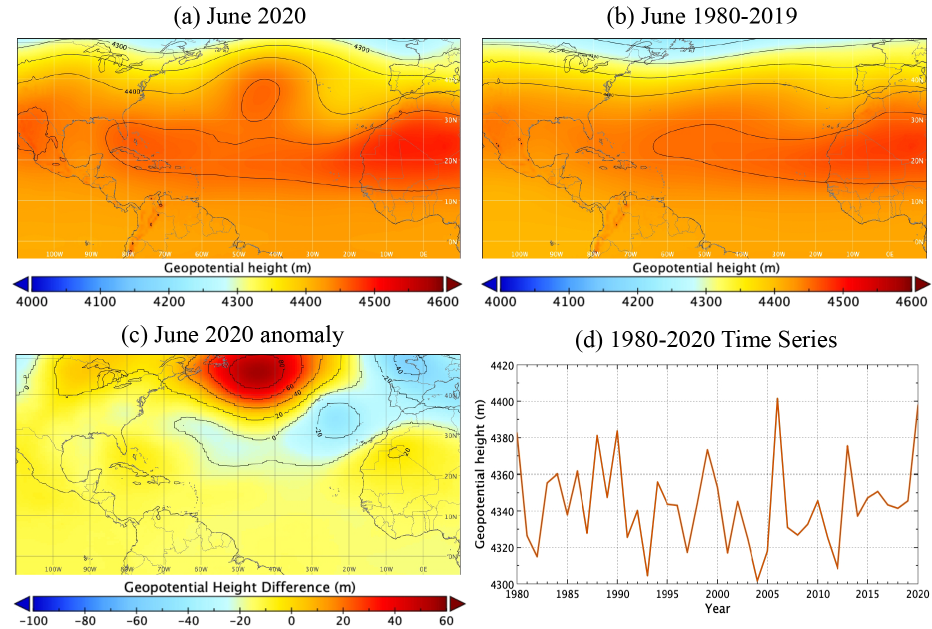
Figure 12. MERRA-2 reanalysis geopotential height at 600hPa: (a) June 2020, (b) June climatology (1980–2019), (c) June 2020 anomaly,